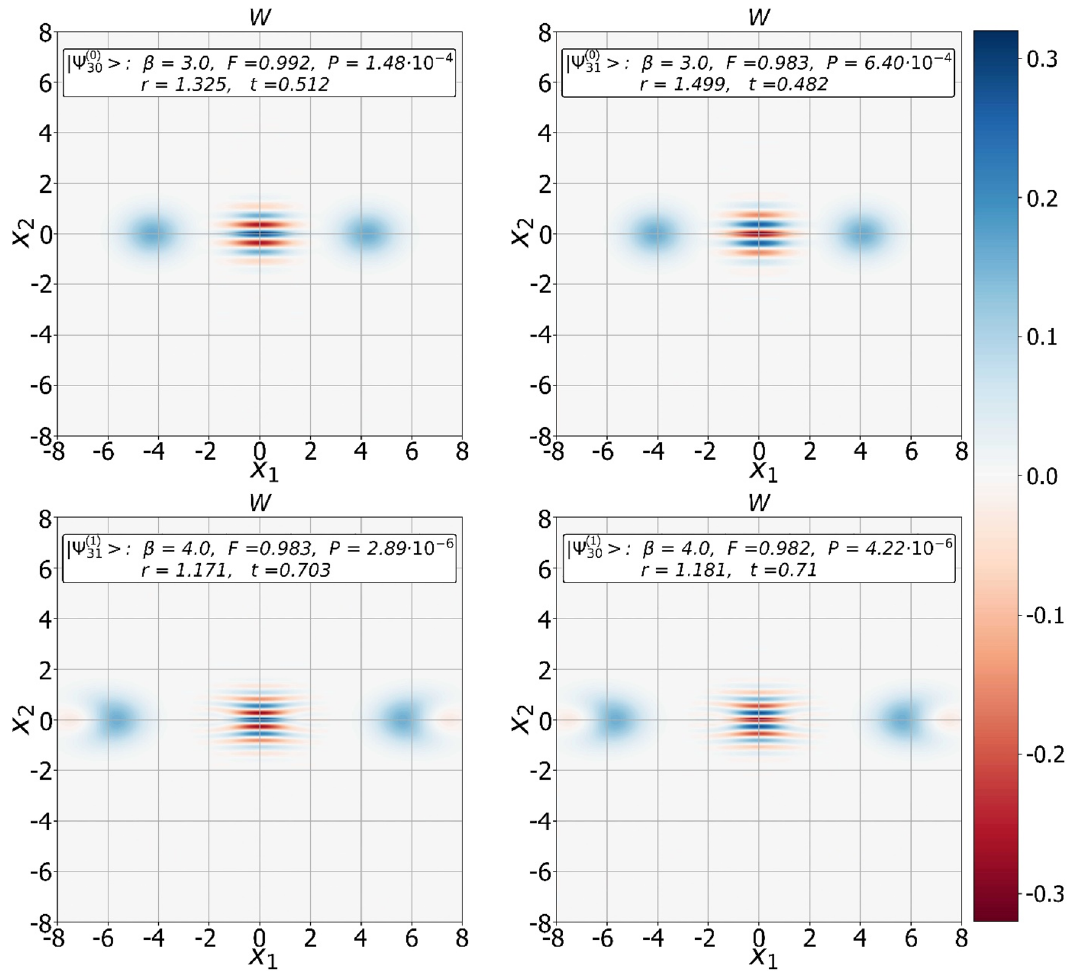
Figure 5. Wigner functions of the even/odd states from � ( 0 ) and � ( 1 ) families approximating even/odd SCSs with high